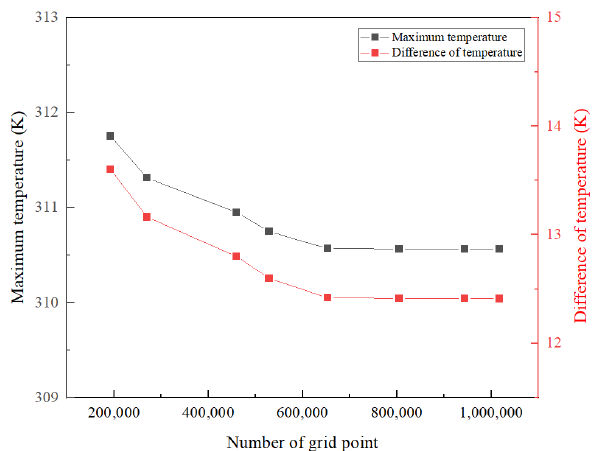
Figure 5. Grid independence test.